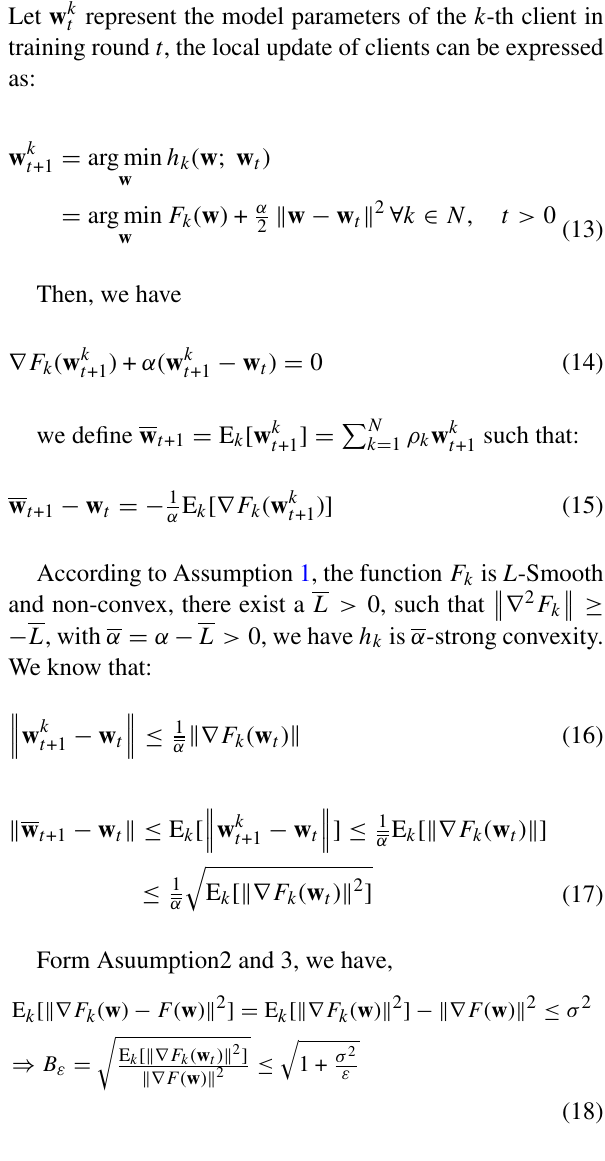
Bold represents the best experiment